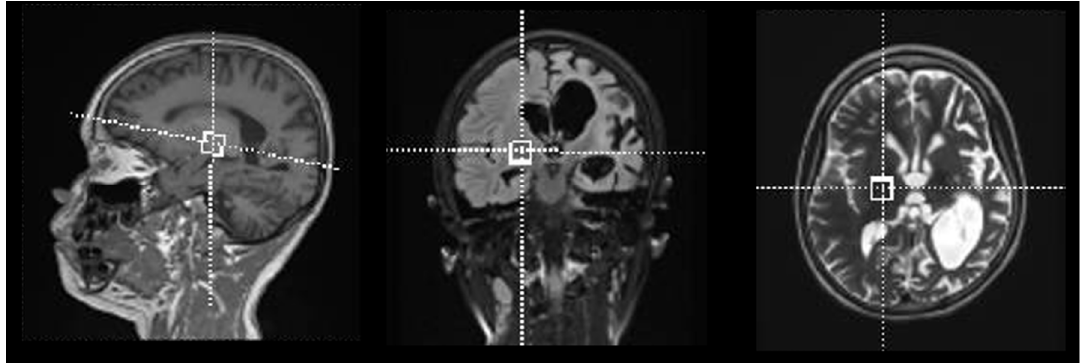
Figure 1. Voxel positioning within right ganglio-capsular region.